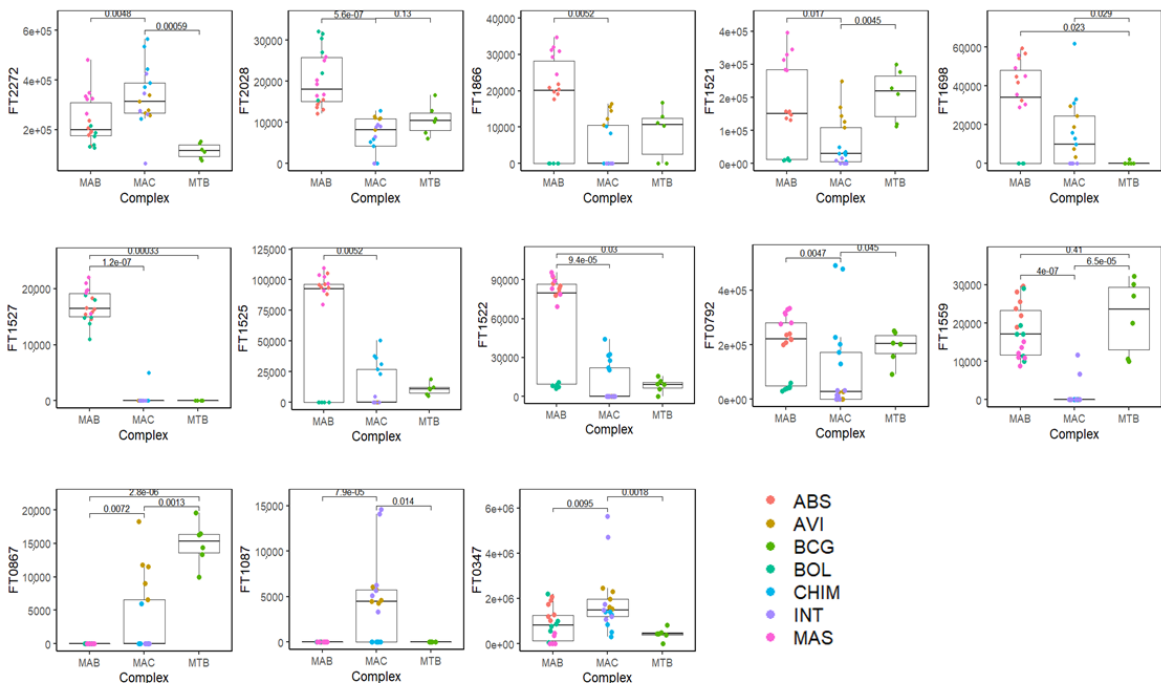
Figure 5. Bar-plot of 13 discriminatory volatile features (FT). Legenda: FT0347, 2-Butanol, 2,3-dimethyl-; FT1087, Hexanal; FT0867, Furan, 2-butyl-; FT1559, Furan, 2-methyl-3-(methylthio)-; FT0792, Phenylacetaldehyde; FT1522, unknown; FT1525, ( Z )-2-Hexenal diethyl acetal; FT1527, Decanal; FT1698, 2-Nonenoic acid, methyl ester; FT1521, unknown; FT1866, unknown; FT2028, unknown; FT2272, Ethyl 4- t -butylbenzoate. Mycobacteria species and complex are reported in Section